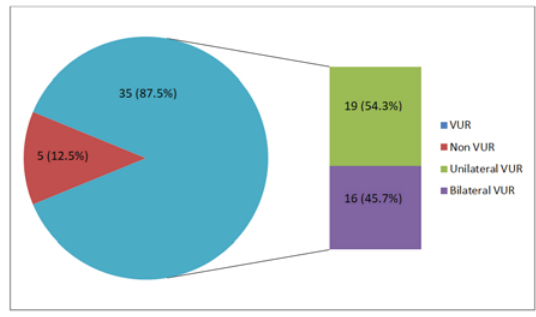
Figure 2. VUR vs Non-VUR